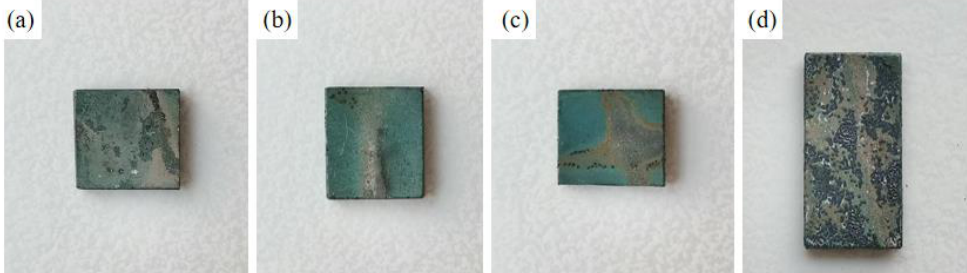
Figure 17. Macroscopic morphologies of Al-Si coatings oxidized at 1000 °C for 300 h under different pre-oxidation times: ( a ) 3 h; ( b ) 5 h; ( c ) 7 h; ( d ) 9 h.